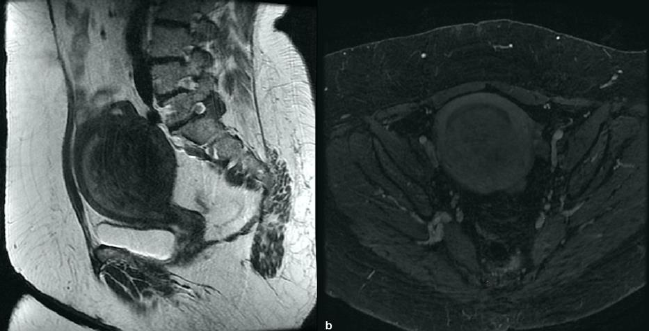
Figure 11. LG-ESS. ( a ) Sagittal T2-weighted image showing a low-signal-intensity adenomyosis-like mass in the posterior wall, which presents an heterogenous enhancement after the administration of Gadolinium, ( b ), contrast-enhanced fat-saturated T1-weighted